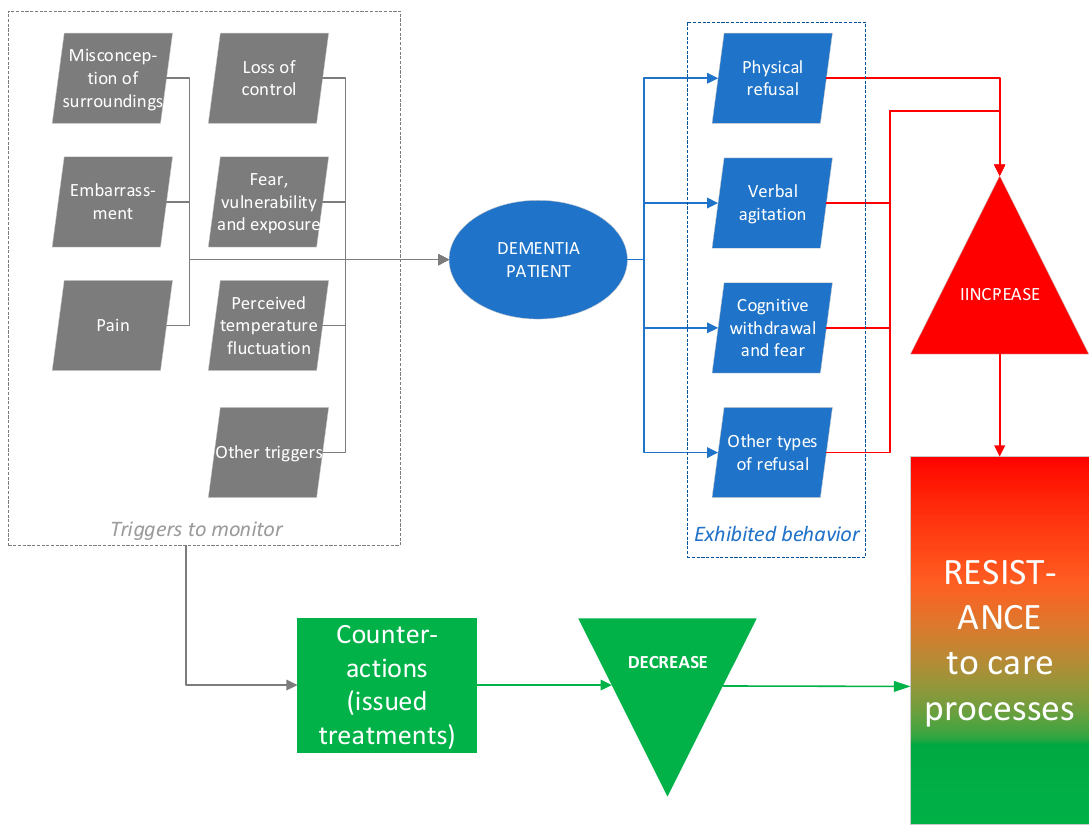
Figure 4. Game model of the avatar’s (person with dementia) reaction to care processes.